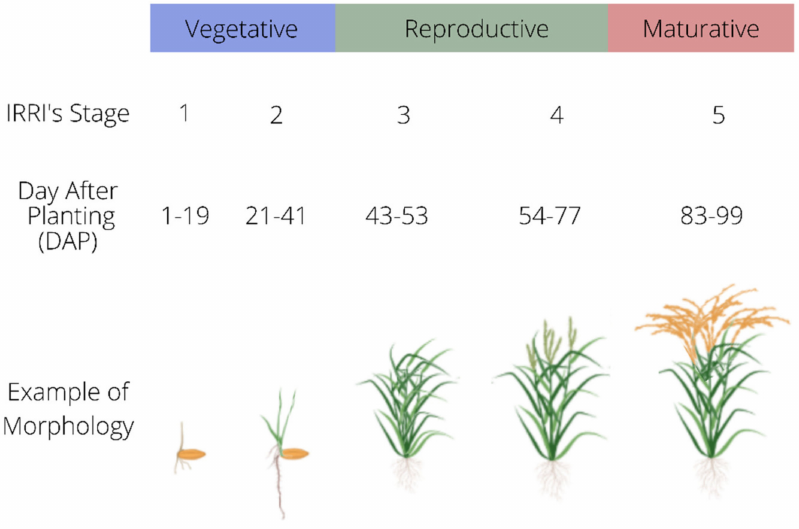
Figure 2. The growth cycle of a rice plant corresponds to the IRRI scale and sample